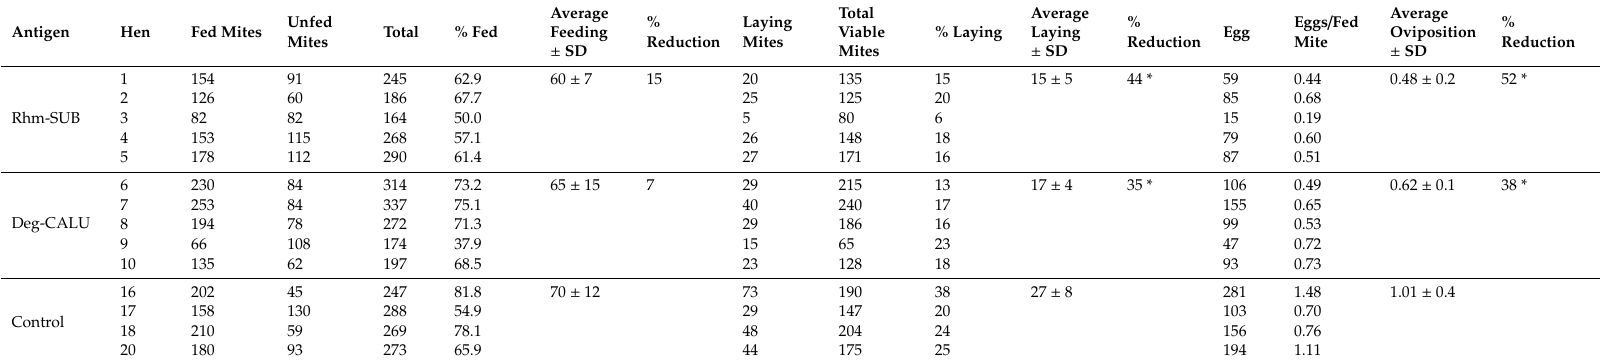
Table 2. Summary of Adult Female PRM Feeding Rates and Vaccine E ffi